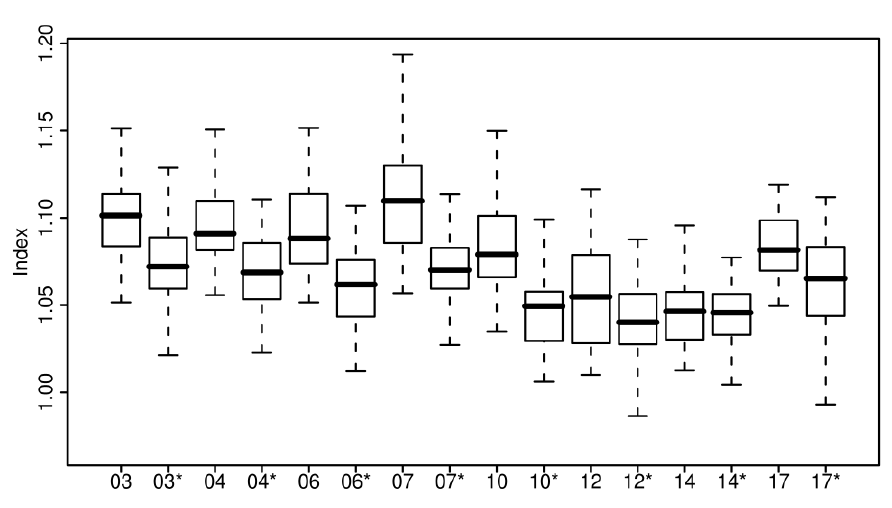
Figure 4. Boxplots representing the behavior of the index R measurement day. The measurement days are shown on the X-axis with * representing measurements on scab inoculated leaves and without * the control